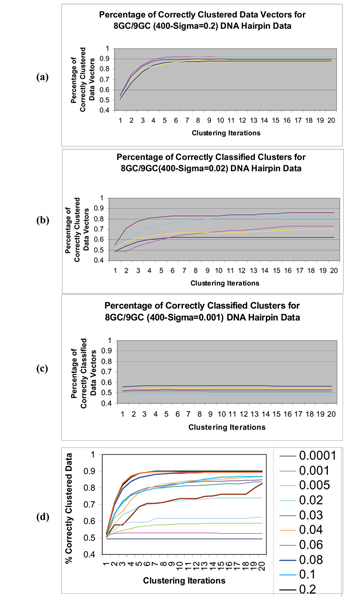
(a) The percentage correct classification (an indication of the clustering success) is shown with successive iteration of the clustering algorithm. Five separate test runs are shown, on different data from the same classes. Note that the plateau at around 0.9, this is approximately the performance of a supervised binary SVM on the same data (i.e., perfect separation isn't possible with this data without employing weak-data rejection). (b) The degradation in clustering performance for less optimal selection of kernel and tuning parameter (variance in case of Gaussian). (c) The degradation in clustering performance for non-optimal selection of kernel and tuning parameter (variance in case of Gaussian). (d) Summary of the degradation in clustering performance for less optimal selection of kernel and tuning parameter – with averages of the five test-runs are used as representative curves for that kernel/tuning selection in the above.